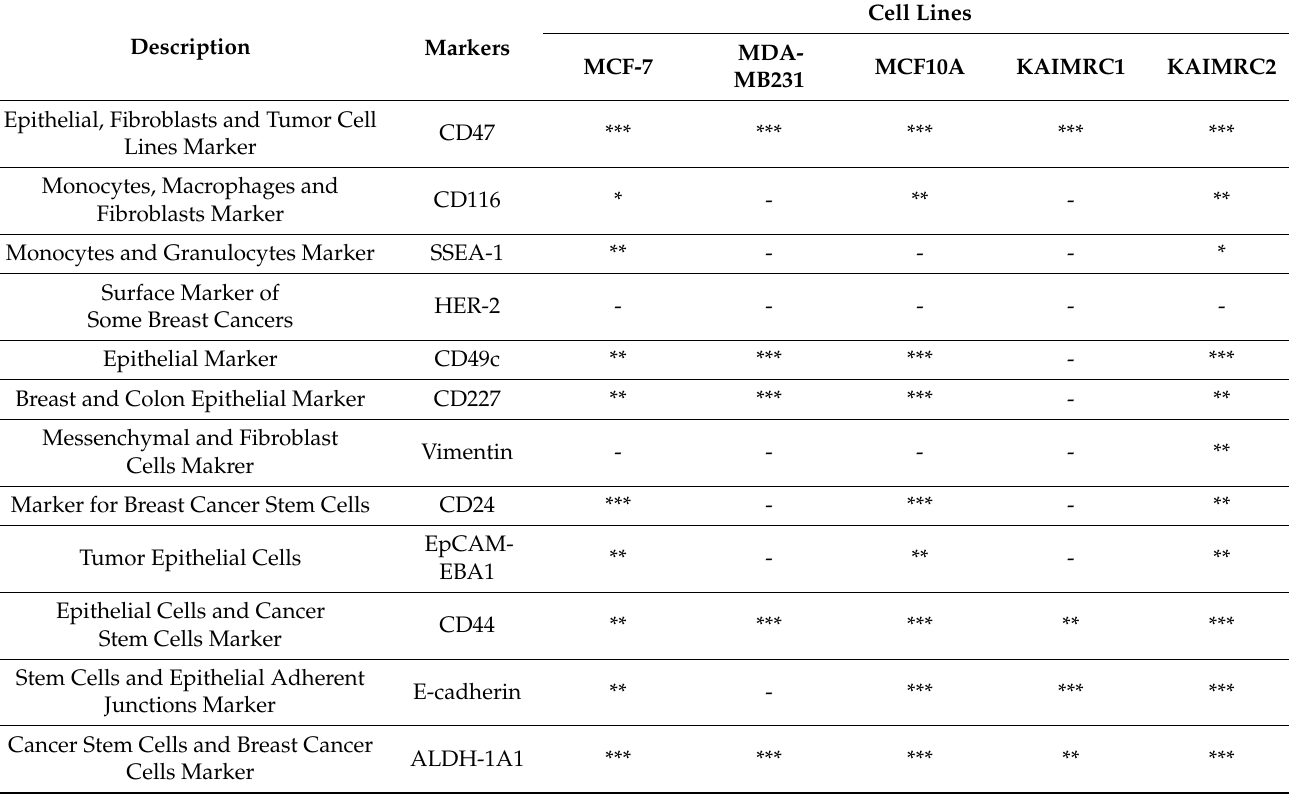
Table 1. Immunoprofiling of the KAIMRC2 cell line. A strong panel of fibroblasts, epithelial, and stem cell biomarkers was used to characterize the cells by flow cytometry. Strongly positive CD47 and CD49c hints toward this cell line’s epithelial lineage, whereas strongly positive CD44, E-cadherin and ALDH-1A1 indicate CSCs potential of the KAIMRC2 cell